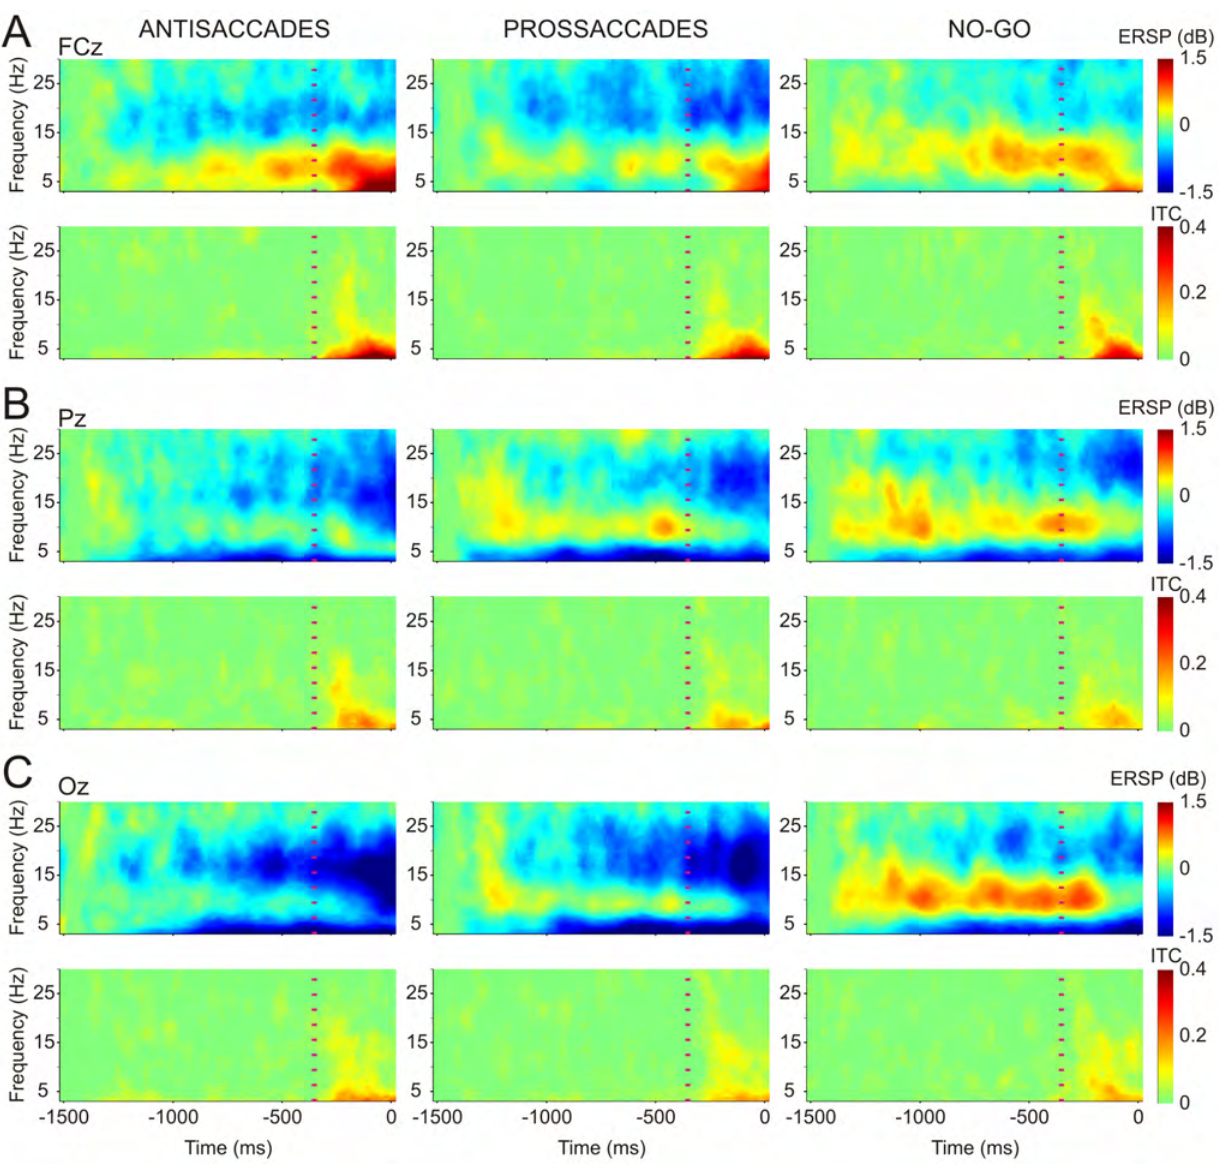
Figure 6. Event-related spectral power (ERSP) and inter-trial coherence (ITC) during the preparatory period. The figure shows the time- frequency analysis at FCz (A), Pz (B) and Oz (C) for antisaccadic (ANTIS), prosaccadic (PROS) and no-go (NG) tasks. For A–C, significant (bootstrap p , 0.01) differences (non-green pixels) in ERSP (first row) and ITC (second row) with respect to the 100 first ms are shown. The vertical dashed red line indicates the onset of the gap period. For ERSP analysis, warm color indicates even-related synchronization and cool color event-related desynchronization. For ITC, warm color indicates increase in phase coherence.